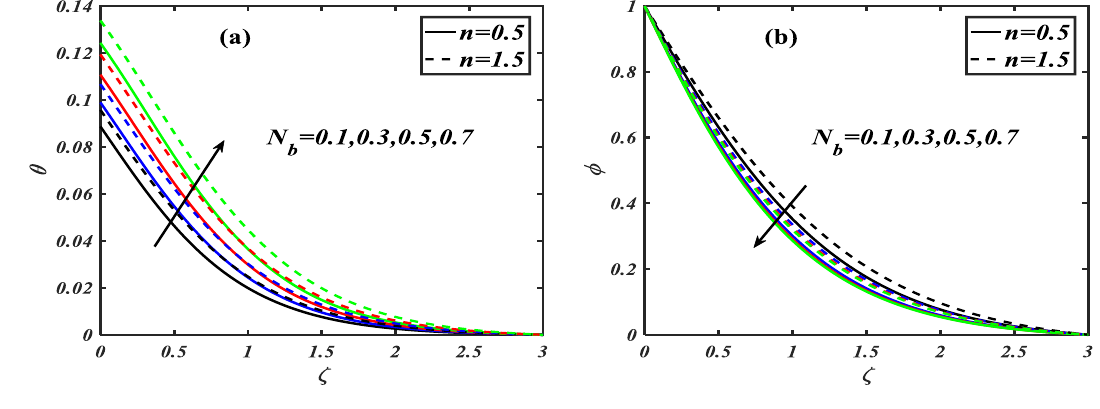
Figure 7. ( a , b ) Illustrating the impact of Brownian motion parameter over θ(ζ) , φ(ζ) .